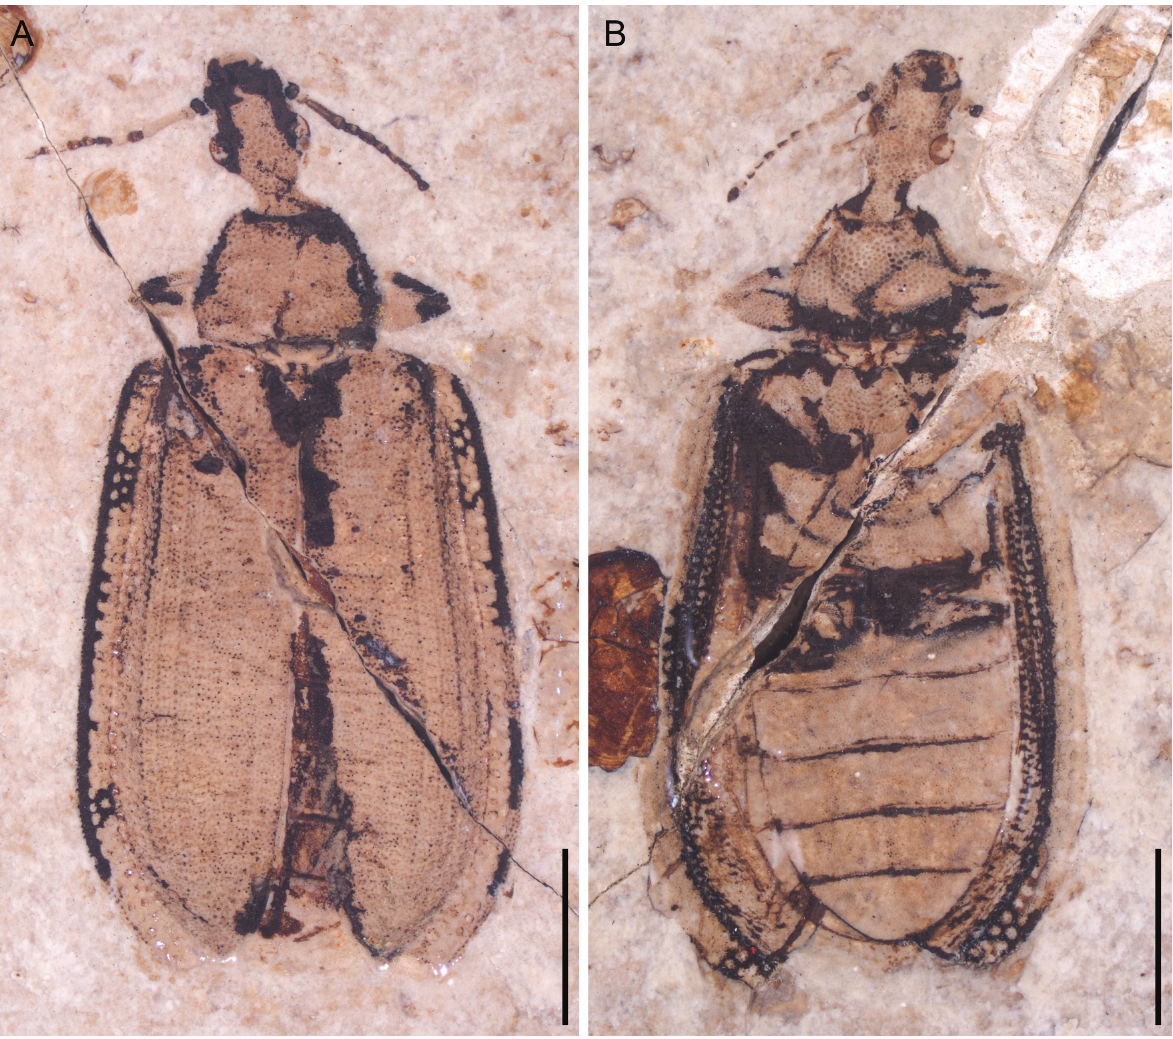
Figure 2. General habitus of Limnomma daohugouense gen. et sp. nov., holotype, NIGP176015, moistened with 70% ethanol, under incident light. A. Part, NIGP176015a; B. Counterpart, NIGP176015b. Scale bars: 4